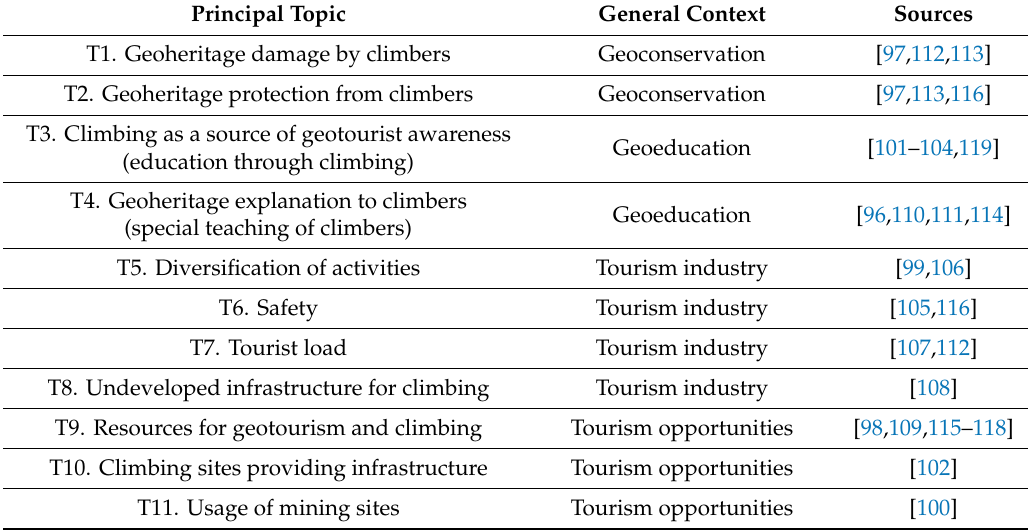
Table 2. Principal topics of the reviewed